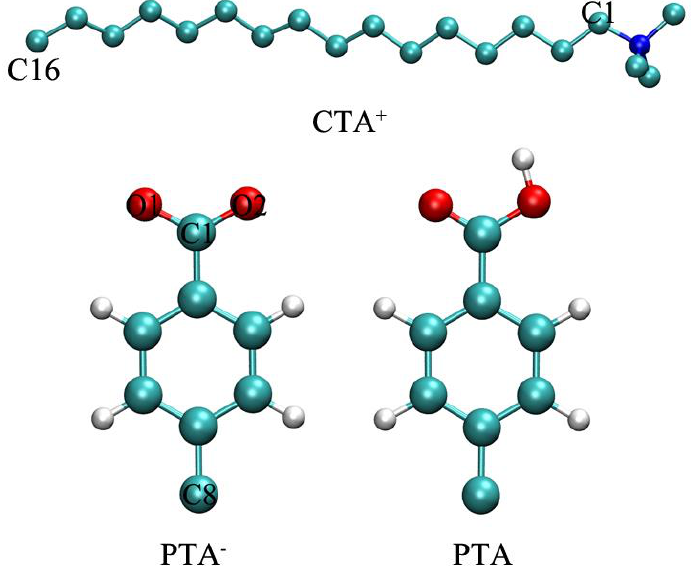
Figure 8. Structures of CTA + , PTA − , and PTA. (Atomic color scheme: C, cyan; O, red; N, blue; and H,